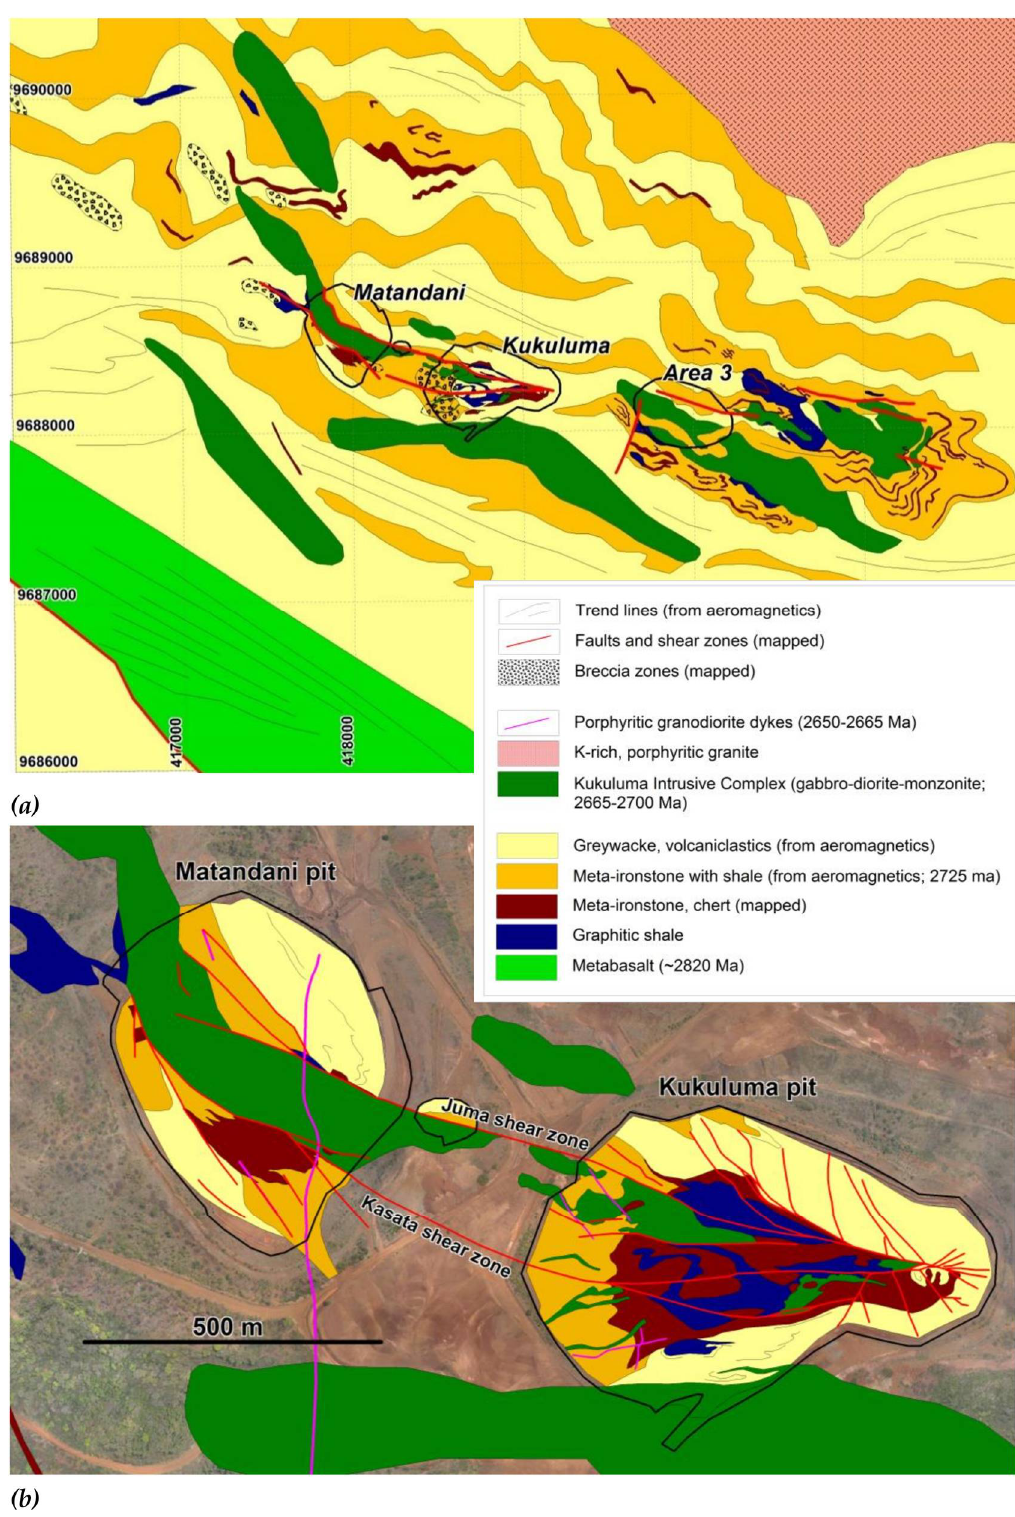
Figure 3. ( a ) Geological map of the central Kukuluma Terrain, showing the position of the main gold deposits in the area. The distribution of the meta-ironstones in the area is derived from geophysics. Map projection is UTM WGS84 zone 36S; ( b ) Close-up view of the Matandani and Kukuluma pits. The age estimates in the legend are from [28–30].